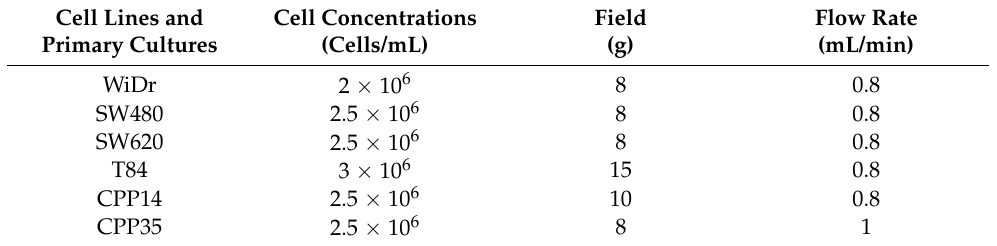
Table 2. Optimal elution condition for cell sorting of CRC cell lines and primary cultures by SdFFF. Cell Lines